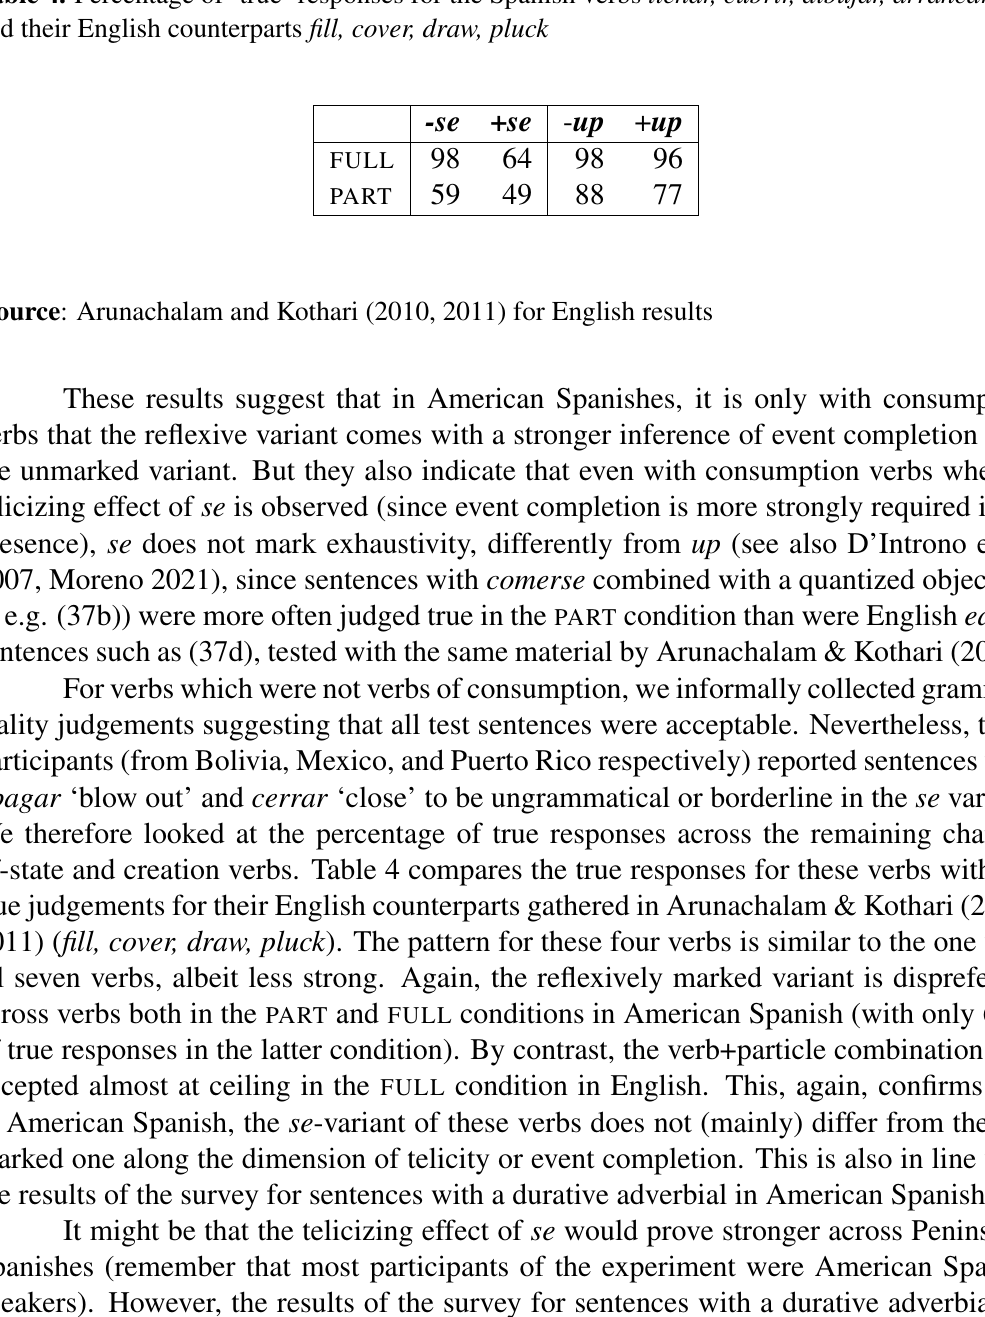
Table 4. Percentage of ‘true’ responses for the Spanish verbs llenar, cubrir, dibujar, arrancar and their English counterparts fill, cover, draw,